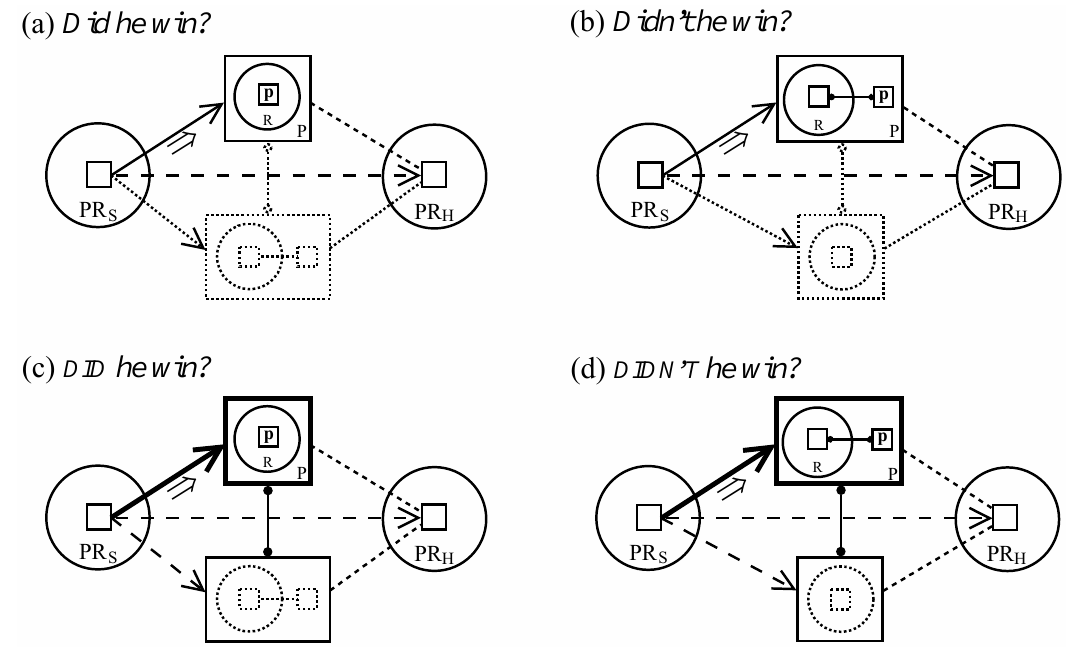
Figure 13. Polarity questions and polarity focusing.